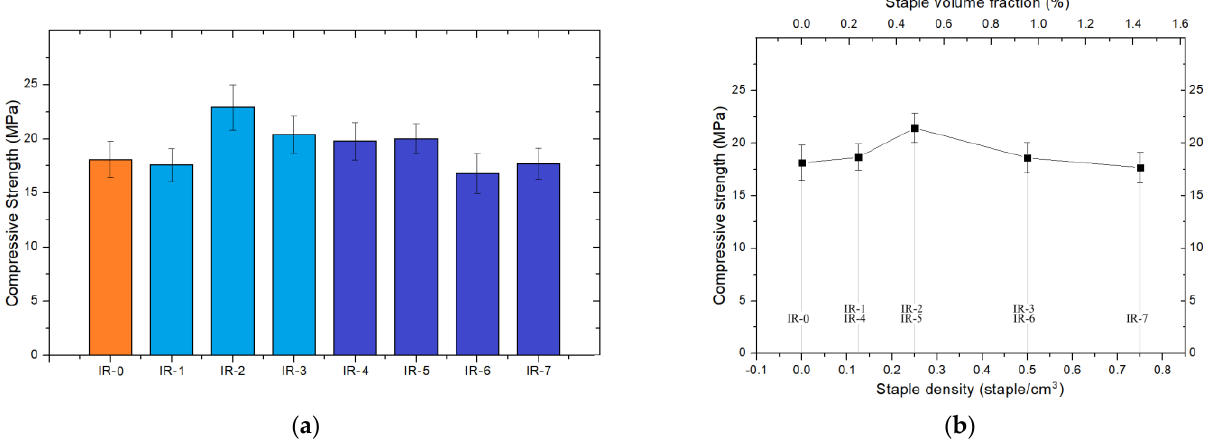
Figure 12. Compressive strengths of the IR- samples. ( a ) Strengths vs. sample type and ( b ) strengths vs. staple density/volume fraction.